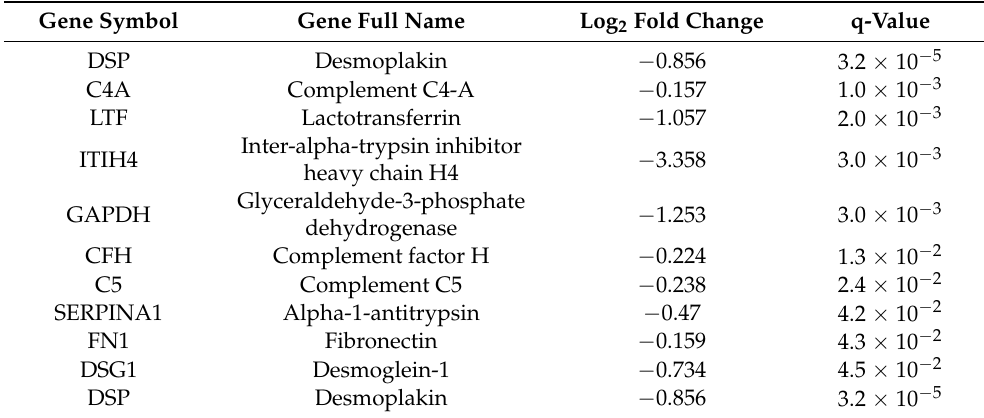
Figure 4. Volcano plot showing the differentially expressed proteins in serum after 6-month treatment with denosumab. The downregulated proteins are colored in blue. Horizontal red line marks the q-value threshold (0.05). Black circles are those proteins under the q-value threshold (not significant). The genes encoding the proteins with significant differences pre- and post-therapy, ordered by q value, are shown in Table 3. Table 3. Differentially expressed proteins in serum after 6-month treatment with denosumab, ordered by q-value.